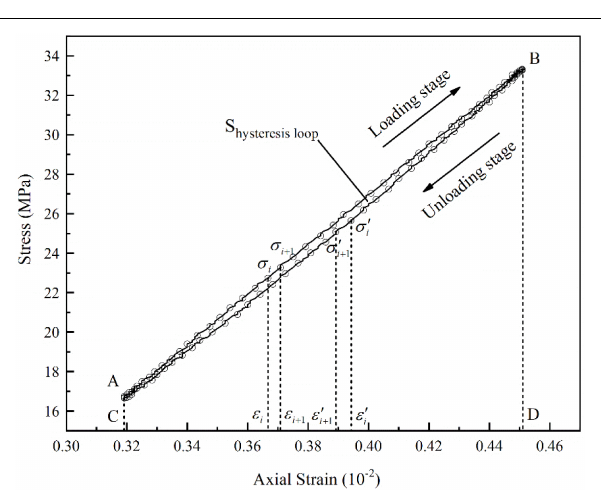
FIGURE 8 | The 7th hysteresis loop at stress level I under 10 F-T